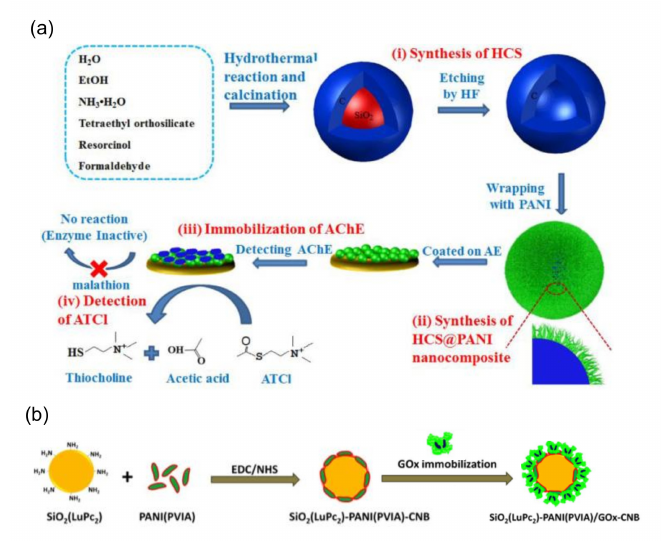
Figure 4. ( a ) Hollow carbon spheres coated with needle-like PANI-based pesticide biosensors